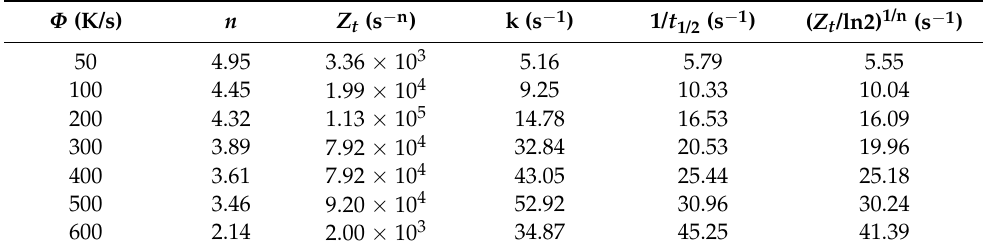
Table 3. Avrami parameters of PEG at different cooling rates.